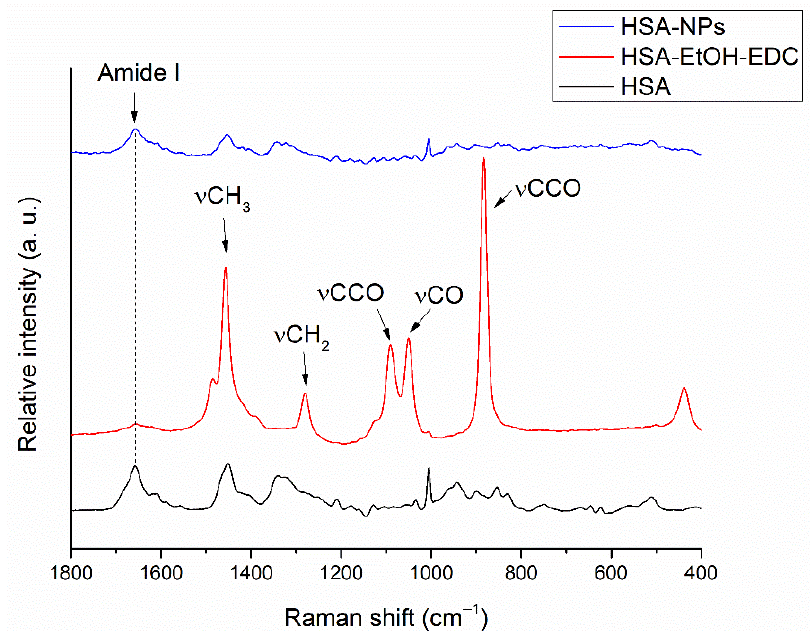
Figure 7. Raman spectrum of HSA aqueous solution (HSA), HSA nanoparticles after desolvating with EtOH and crosslinking with EDC (HSA-EtOH-EDC), and HSA nanoparticles after purifying with centrifugation (HSA-NPs).